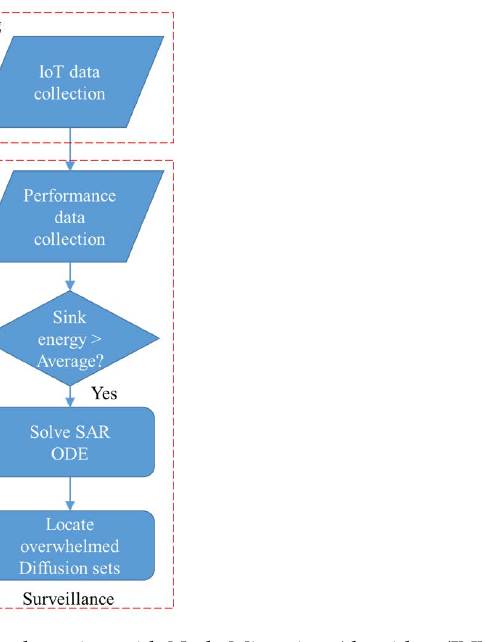
Figure 6. The Interference aware clustering with Node Migration Algorithm (INMA)